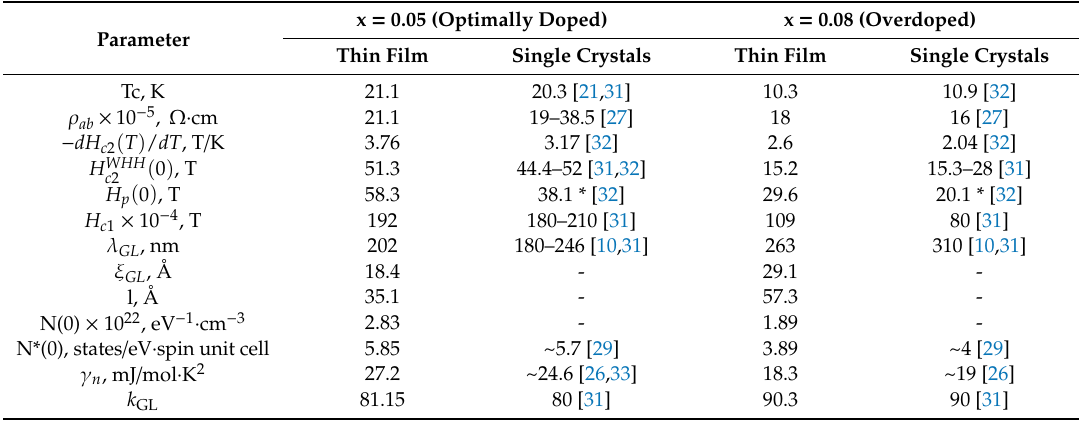
Table 2. Electronic parameters of the Ba(Fe 1 − x Ni x ) 2 As 2 thin films and single crystals.